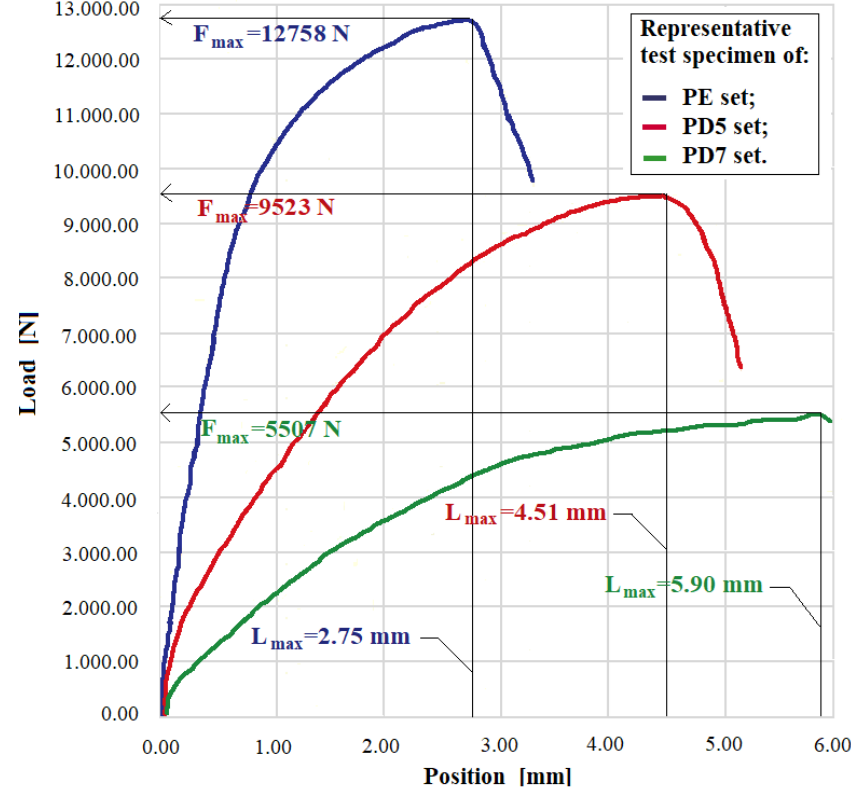
Figure 11. Deformation–force diagram for representative specimens from PE, PD5 and PD7 sets. The mean value and the mean square deviation for the maximum load force F max (N) and the maximum deformation L max (mm) for the sets of the specimens of type PE, PD5 and PD7 are given in Table 4. Table 4. Mean value and standard deviations for maximum load force F max (N) and maximum deformation L max (mm) for PE, PD5 and PD7 specimen